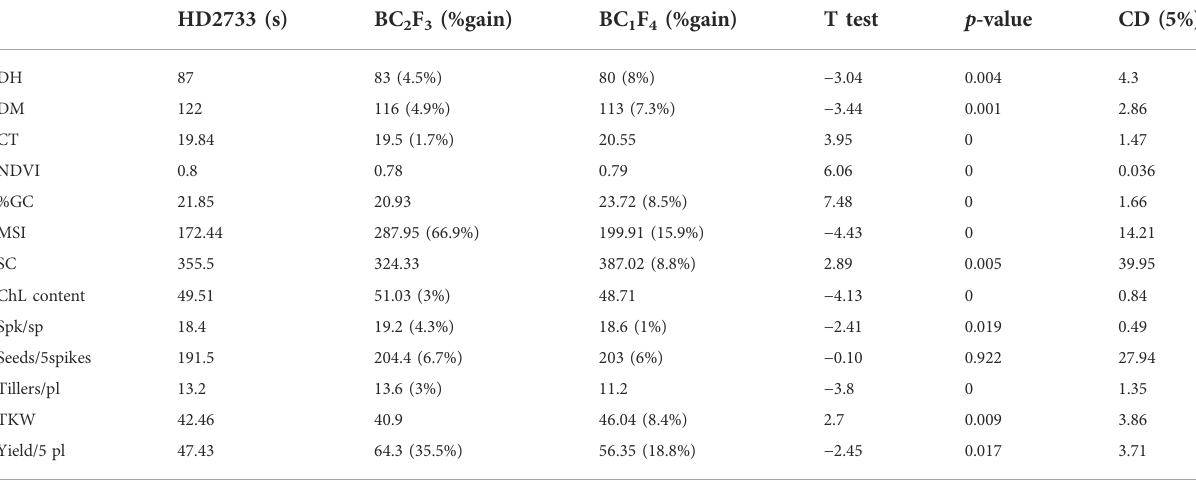
TABLE 4 Morpho-physiological trait observations of recurrent parent and derived lines under heat